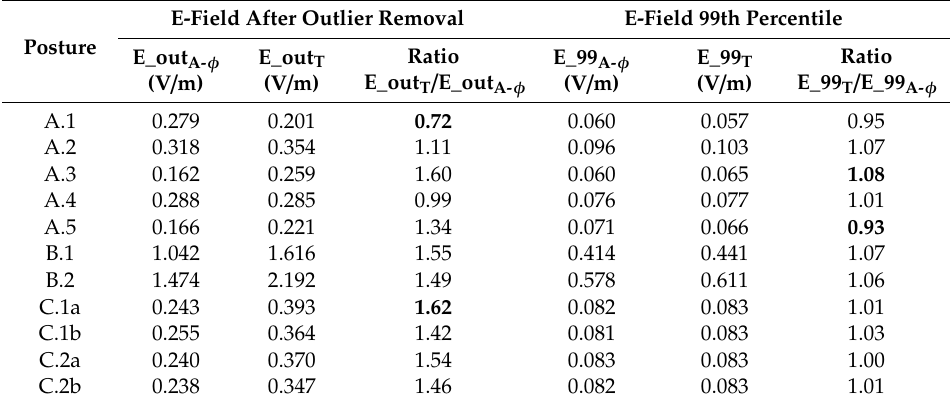
Figure 4. Example of data filtering applied to raw data (values obtained with a unitary current amplitude imposed to the conductors) computed with the two solvers for Posture A.2. On the upper plots, the frequency distributions of the natural logarithm of the gradient of the sorted values of the E-field magnitude. On the lower plots the correction of data applying the filtering technique. On the left the data for the A - φ solver, on the right the data for the T solver. Table 3. Maximum values of E-field obtained for the two solvers after filtering for outlier removal (E_out T and E_out A- φ ). The values filtered with the 99th percentile are also reported for both solvers (E_99 T and E_99 A- φ